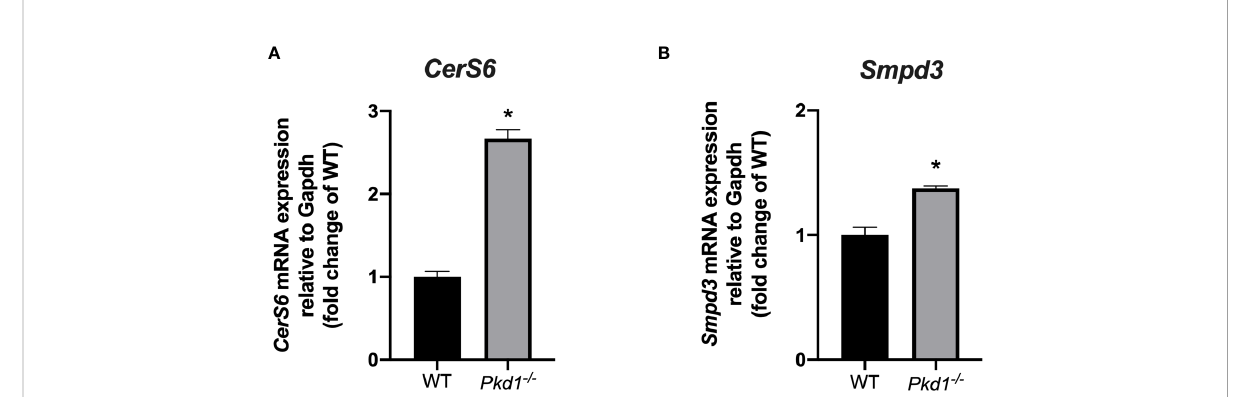
FIGURE 5 Effect of Pkd1 knockout on the expression of ceramide biosynthesis enzymes. The expression of the CerS6 (A) and Smpd3 (B) in wild type (WT) and Pkd1 -/- mDCT15 cells was analyzed by qPCR and normalized to the expression of Gapdh , used as housekeeping gene. Data (mean ± SEM) are expressed as fold change of the expression in the wild type cells. * indicates statistical difference from WT (p < 0.05, n =